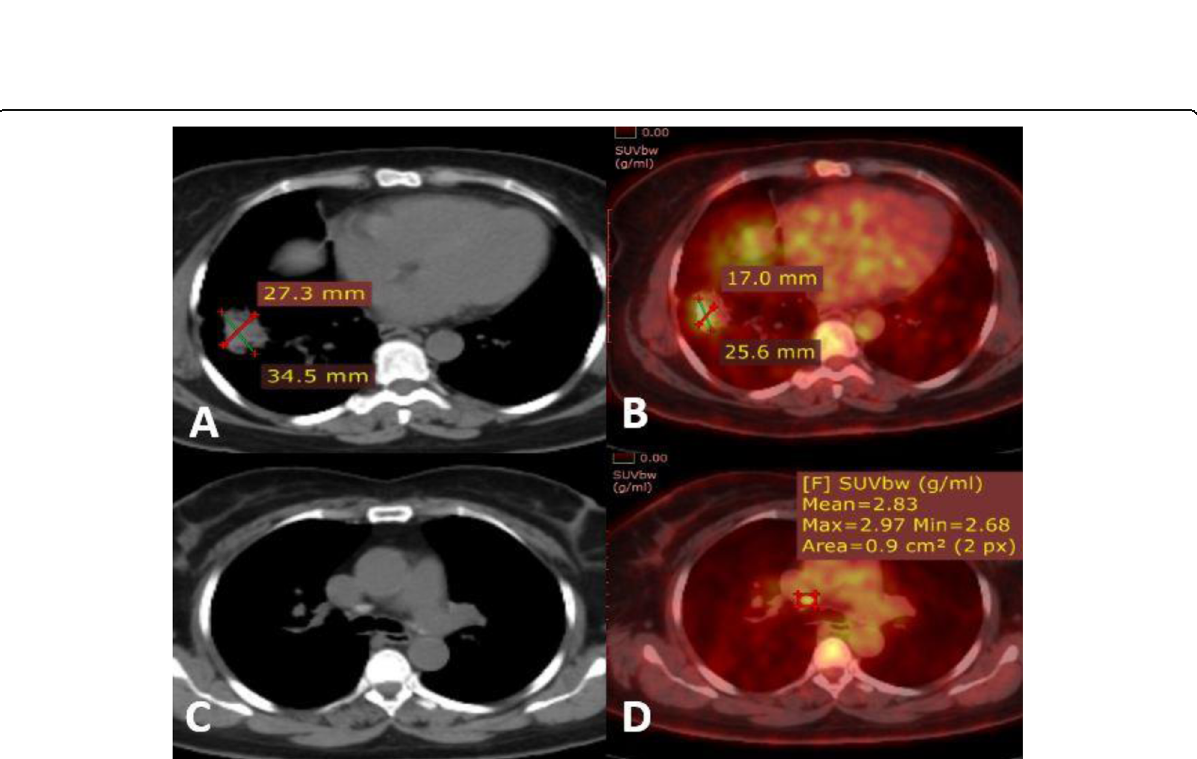
Fig. 4 A female patient 72 years old presented with hemoptysis and proven histopathologically to have NSCLC. CT study reveals a malignant mass lesion involving the right lower lobe measuring 34.5 × 27.3 mm staged as T2 ( a ) with sub-centimetric right para-tracheal lymphadenopathy considered to be nonspecific and staged as N0 ( c ). Her PET/CT revealed right lobe mass lesion measuring 25.6 × 17 mm in average staged as T1 with a downgrade of the CT-T staging separating the actual tumoral tissue from the surrounding pulmonary non-malignant changes with positive activity detected at the right para-tracheal lymphadenopathy staged as N1 instead of N0 diagnosed by CT ( b , d ). The surgical staging of the patients by PET/CT changed from IA to